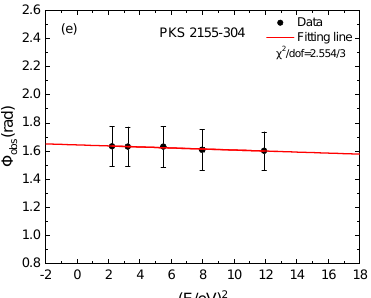
Figure 1. Best -fitting results of the optical spectropolarimetric data of five blazars. ( a ): Linear fit of 3C 66A. ( b ): Linear fit of S5 0716+714. ( c ): Linear fit of OJ 287. ( d ): Linear fit of MK 421. ( e ): Linear fit of PKS 2155-304. The black dots correspond to the time-averaged linear polarization data, and the red lines are the theoretical curves based on Equation